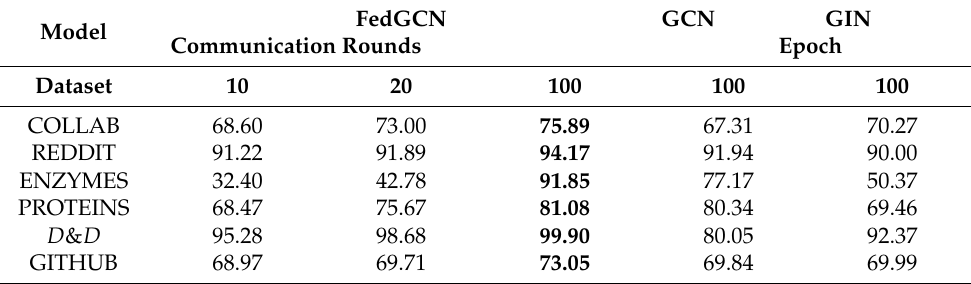
Table 2. Federated learning global model accuracy at different iterations